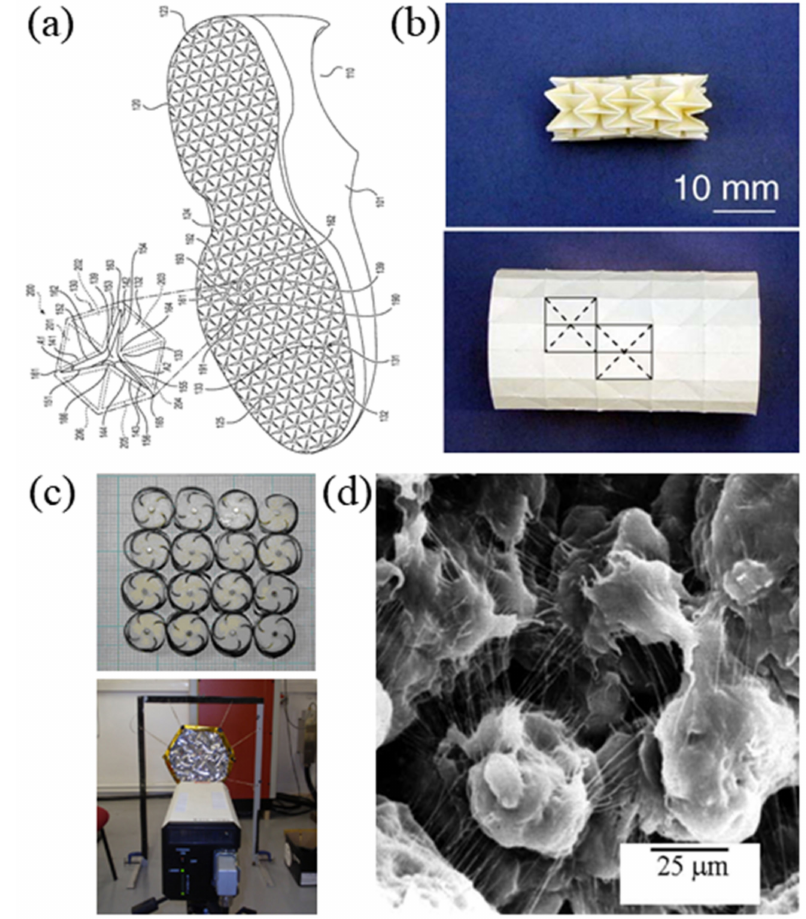
Figure 21. Applications of auxetic structure: ( a ) footwear (sports science) [115], ( b ) angioplasty stents (medical science) [116], ( c ) shape memory alloy cellular antenna (sensors and actuators) [117], and ( d ) auxetic polyethylene (textiles)